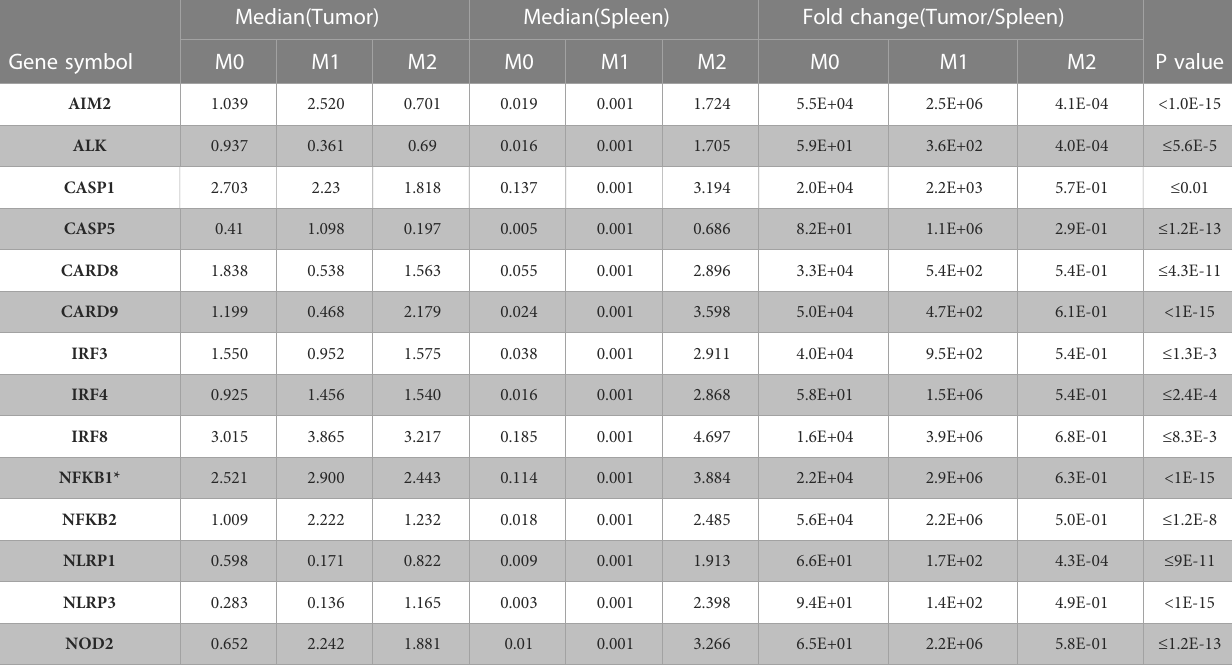
TABLE 1 In fl ammasome components differentially expressed in the three macrophage subtypes in DLBCL.